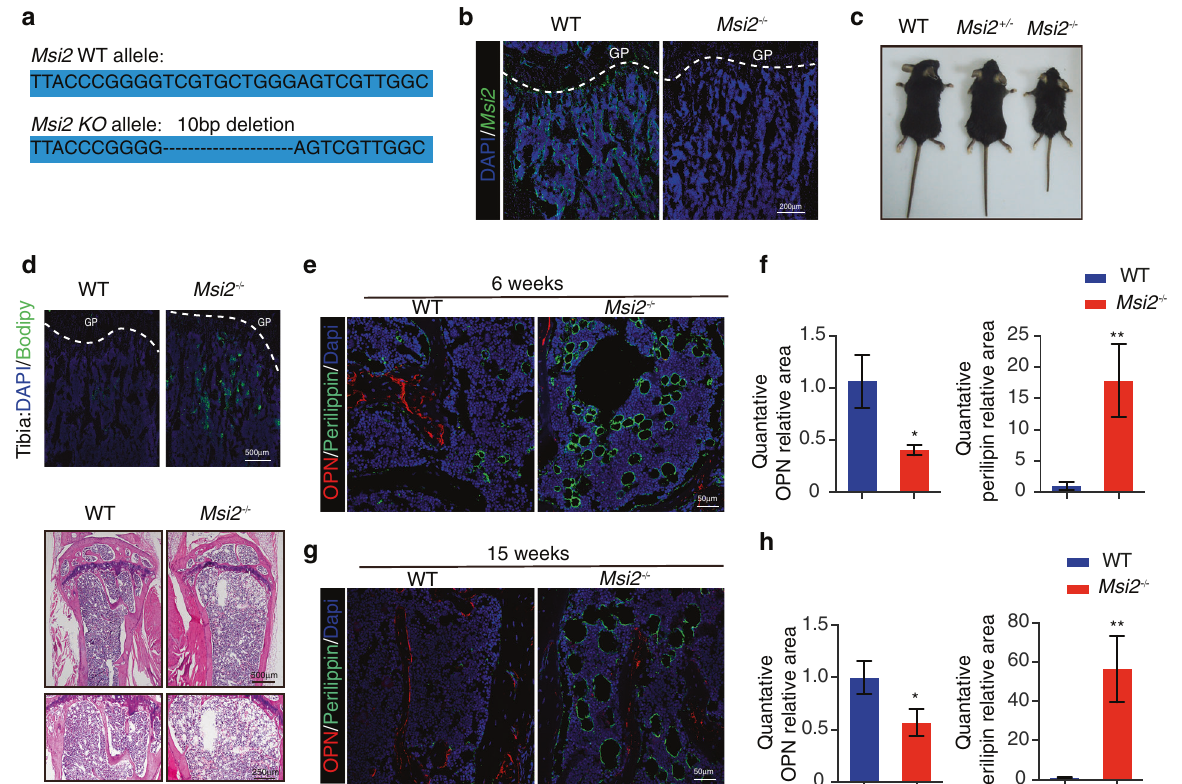
Fig. 2 Msi2 -de fi cient mice show increased bone marrow adipocytes. a Mouse construction strategy. b Immunostaining of MSI2 (green) and DAPI (blue) in tibiae from 6-week-old WT and Msi2 − / − mice. Scale bar = 200 μ m. c Representative view of the wild-type, Msi2 + / − , and Msi2 − / − 6-week-old mice. d BODIPY (green) staining of tibiae from the 6-week-old WT and Msi2 − / − mice. Scale bar = 500 μ m (top). Hematoxylin-eosin staining of femurs from the 30-week-old WT and Msi2 − / − mice. Scale bar = 500 μ m (middle). Scale bar = 500 μ m (down). e Immunostaining of perilipin A/B (green) and OPN (red) of femurs from the 6-week-old WT and Msi2 − / − mice. Scale bar = 50 μ m. f Quanti fi cation of the relative areas of OPN and perilipin in ( e ). g Immunostaining of perilipin A/B (green) and OPN (red) of femurs from the 15-week-old WT and Msi2 − / − mice. Scale bar = 50 μ m. h Quanti fi cation of the relative areas of OPN and perilipin in ( g